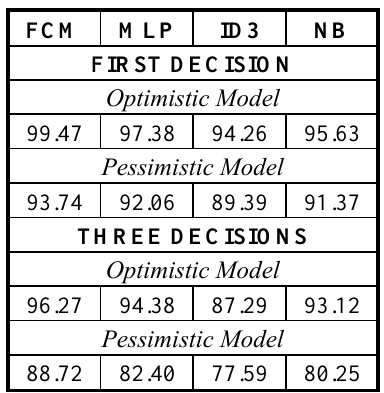
Table 2. Classification percentage per Technique ( FCM, MLP, ID3, NB ), Experiment ( First or Three Decisions ) and Model ( Optimistic or Pessimistic